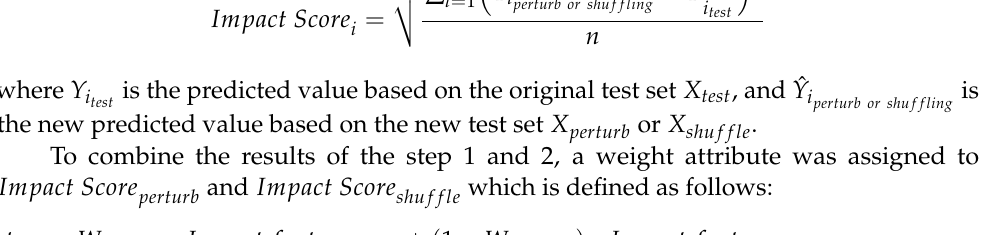
Figure 5. Daily con fi rmed COVID-19 cases for age groups 0–9 and 10–19 in ( a ) 2020, ( b ) 2021, and ( c ) 2022. The blue line shows the daily cases for the 0–9 age group, while the orange line shows the daily cases for the 10–19 age group.